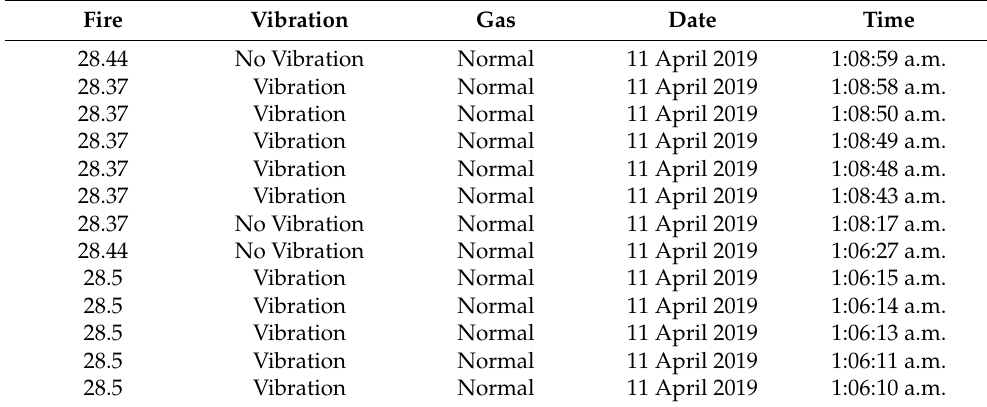
Table 3. Time efficiency of the vibration sensor in transmitter node–01.